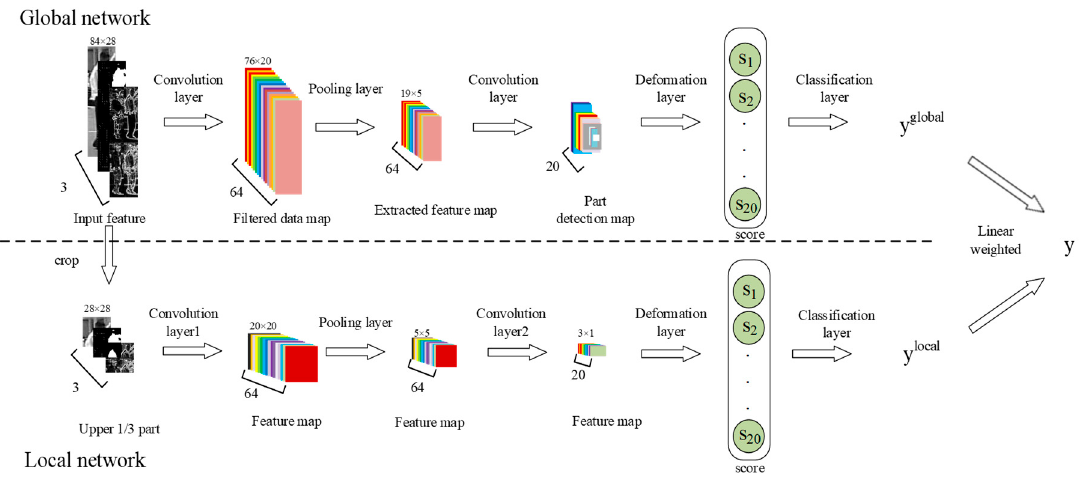
Figure 6. The two-stream UDN.